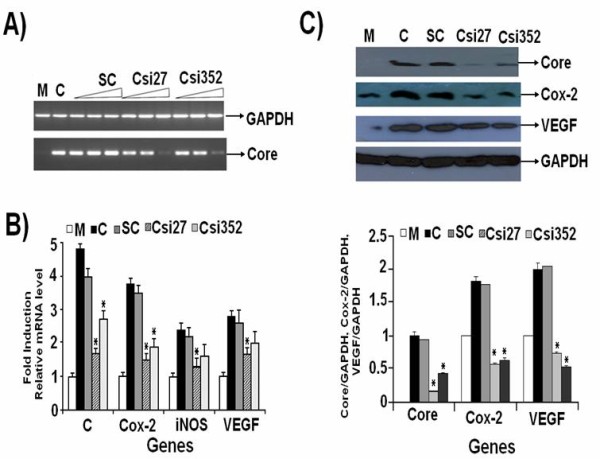
HCV 3a Core-specific siRNA inhibit expression of genes involved in HCV pathogenesis. Huh-7 cells were transfected with HCV 3a Core expression vector or mock along with or without siRNA. (A) Dose dependent mRNA expression of HCV 3a Core gene as a result of 10 μM, 20 μM and 40 μM of siRNAs for 48 hrs. Cells were harvested and relative RNA levels in PCR Csi27 and Csi352 siRNAs tranfected cells were determined using semi-quantitative PCR. Expression levels for mock-transfected (M), HCV 3a Core expression plasmid (C), scramble siRNA (SC) and GAPDH are also shown. (B) Silencing effect of HCV 3a Core gene on the RNA expression levels of cellular genes (Cox-2, iNOS and VEGF) 48 hrs post transfection on Real-Time PCR using gene specific primers in comparison to mock was performed. GAPDH was used as internal control. Three independent experiments were performed having triplicate samples. Error bars indicate, mean S.D, *p < 0.001 verses Core. (C) Silencing of HCV 3a Core gene and its effect on Cox-2 and VEGF protein level using specific antibodies were determined by Western blot analysis after 48 hrs transfection in Huh-7 cells with GAPDH as internal control. Bars are mean of optical density ratio of each group.* p < 0.001 verses control and Core 3a.